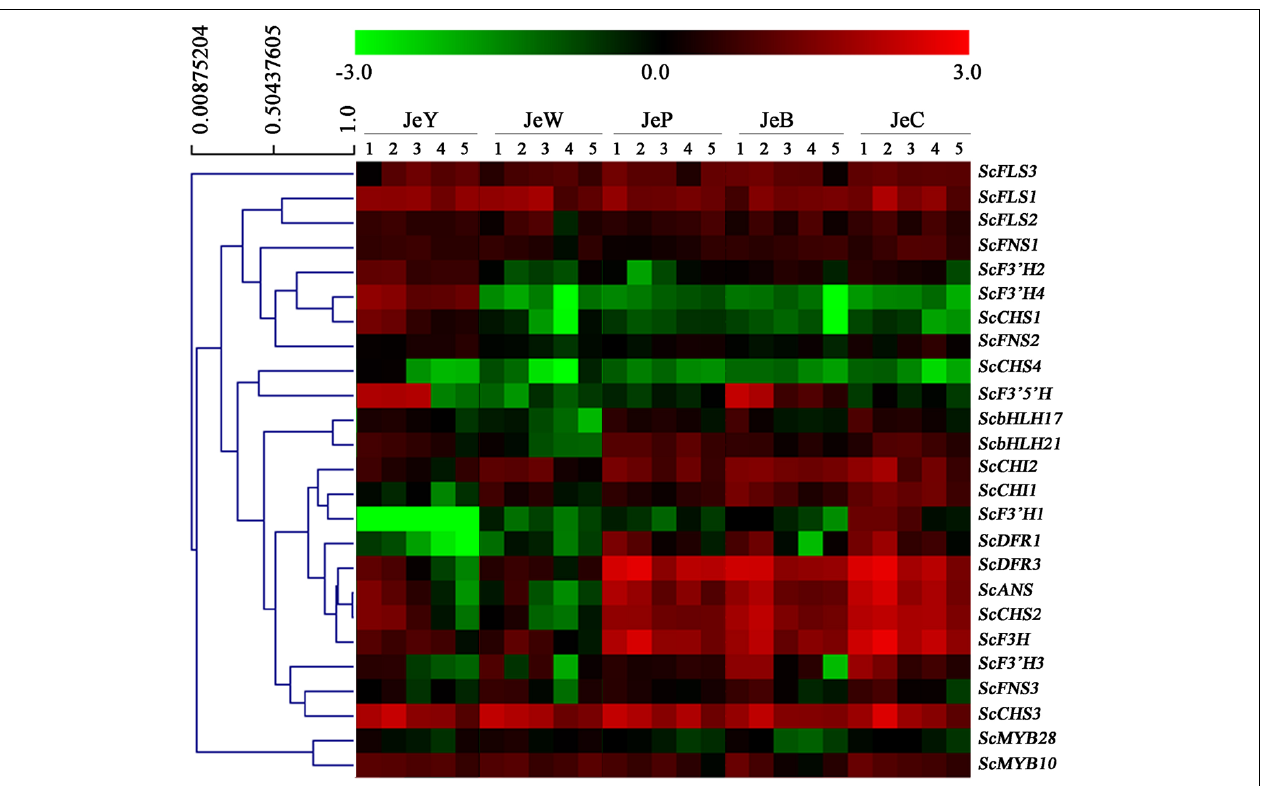
FIGURE 5 | Phylogenies analysis and RT-PCR of R2R3-MYB and bHLH genes in S.